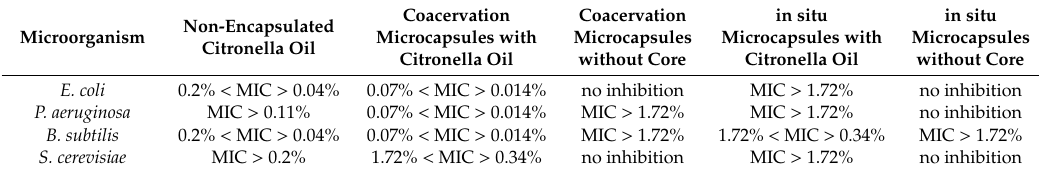
Table 7. MIC determination of free and microencapsulated citronella